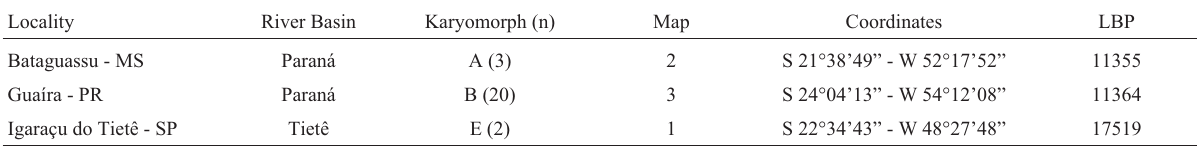
Table 1 - Synbranchus marmoratus specimens